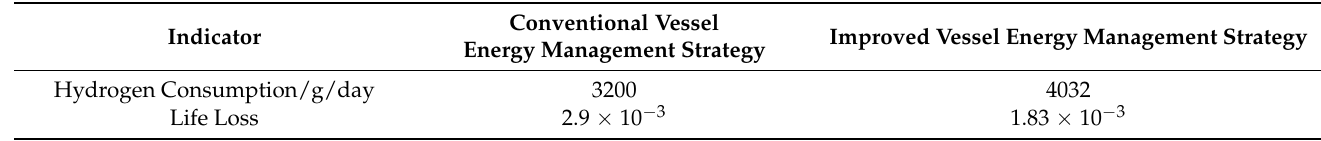
Table 7. Comparison of the results of each index before and after considering the depth of discharge of lithium batteries.